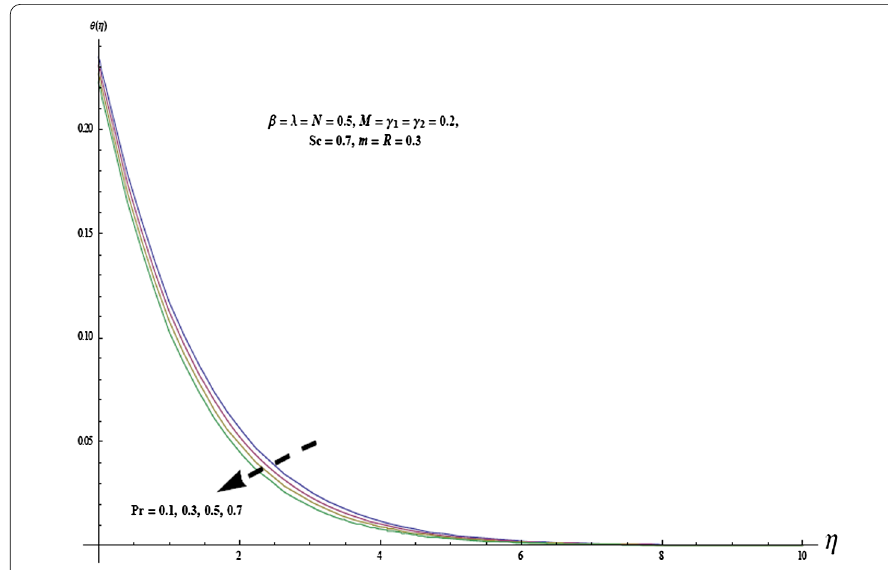
Figure 12 Variation of Pr on θ ( η ).